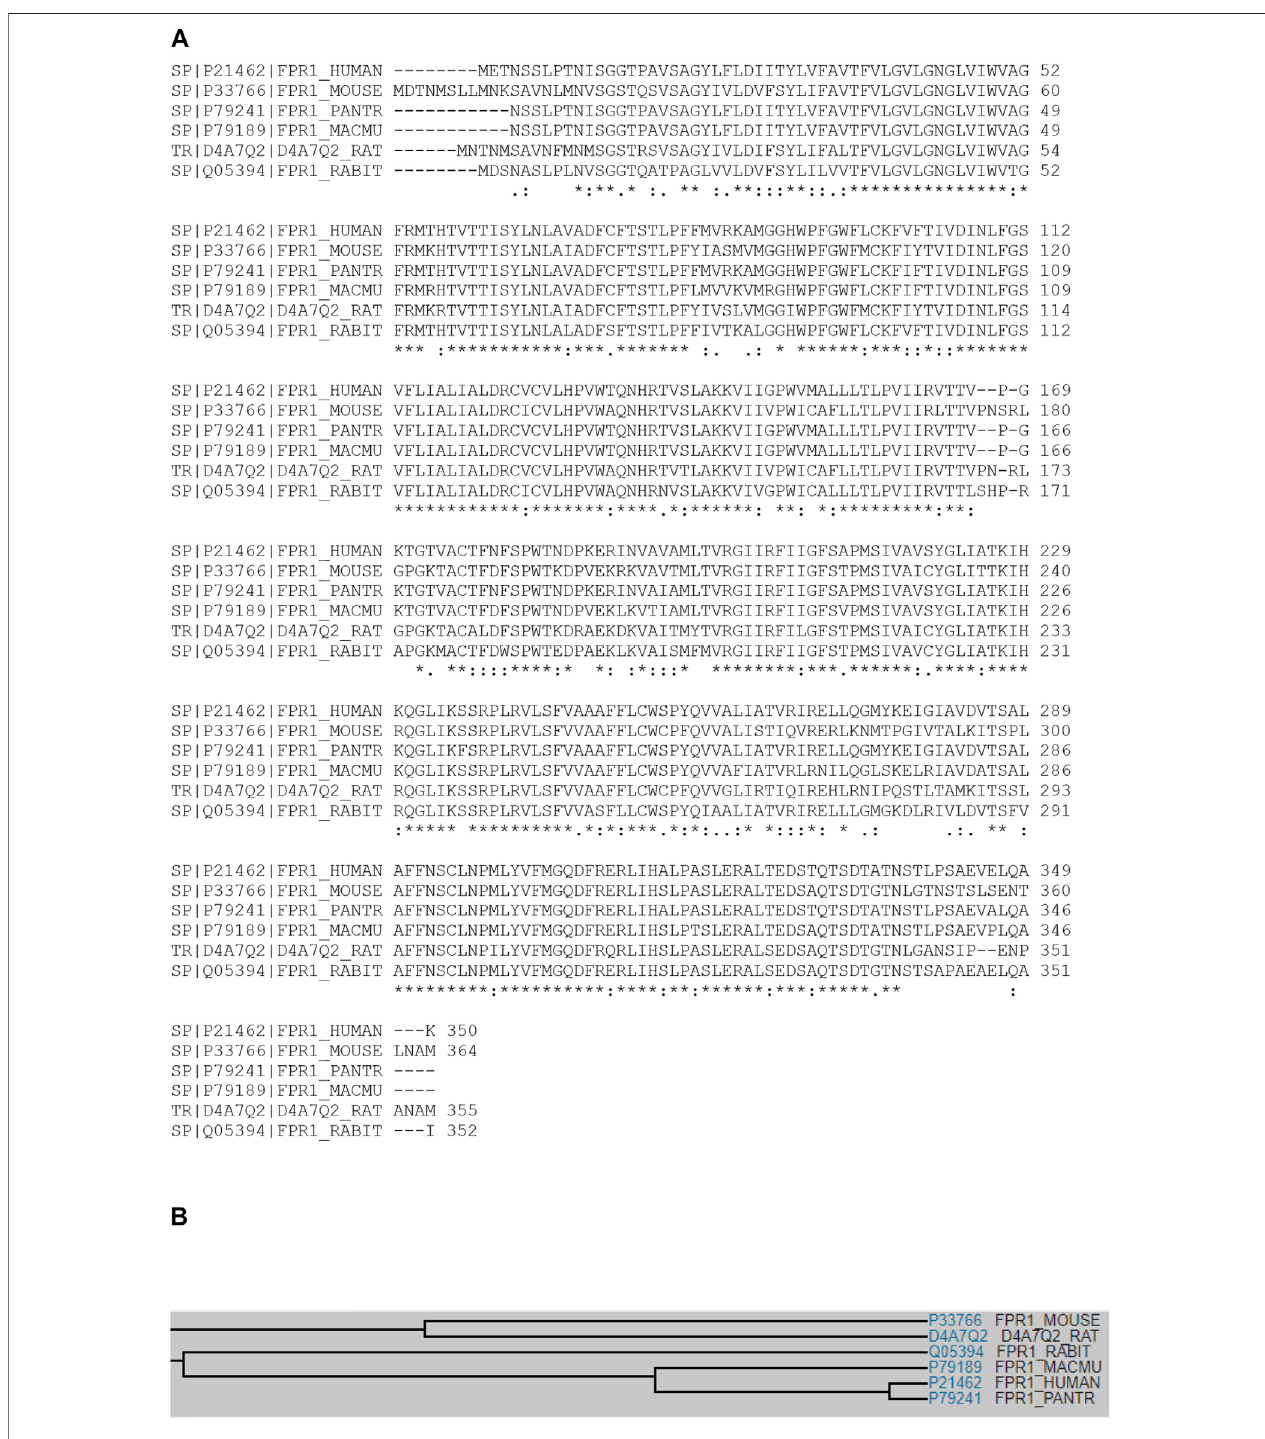
FIGURE 5 | Multiple sequence alignment of FPR1. (A) Multiple sequence alignment analyses show that FPR1 shares sequence identity and similarity with FPR1 homologues among various species including human, mouse, chimpanzee, Rhesus macaque, rat, and rabbit (https://www.uniprot.org/align). (B) A family tree of FRP1 homologue proteins is